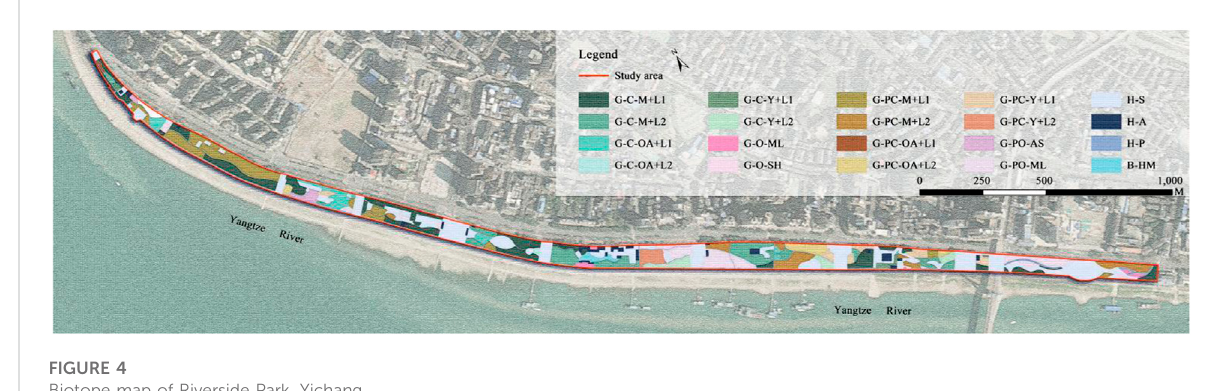
FIGURE 4 Biotope map of Riverside Park, Yichang.